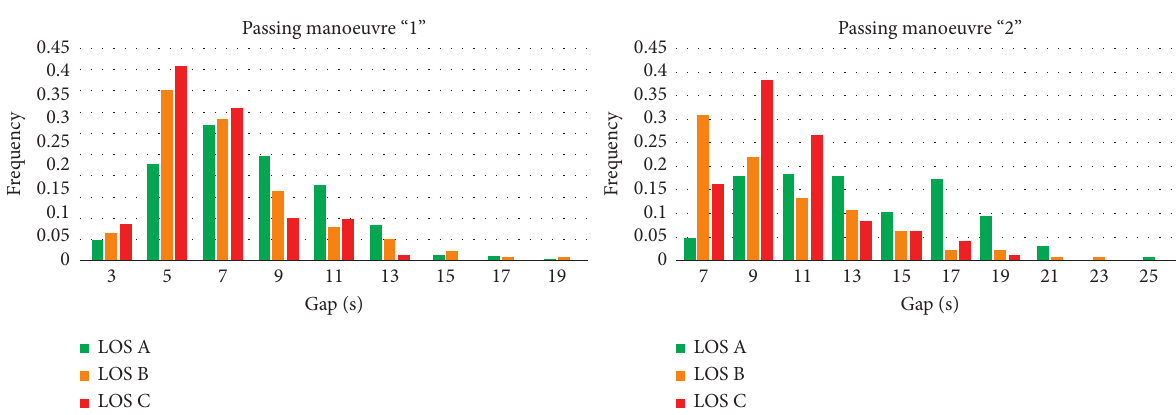
Figure 7: Histograms of gap distributions for recorded passing manoeuvre of types “1” and “2.” Table 7: Mean value and standard deviation of the gap, TTC, and risky manoeuvres. Type of passing